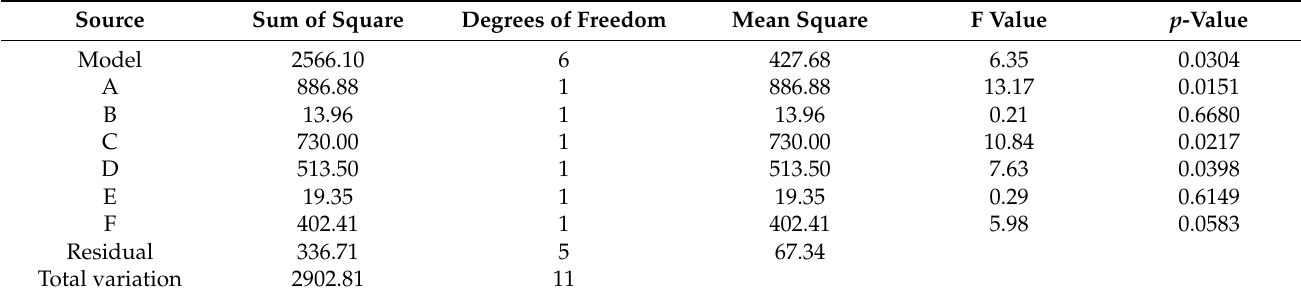
Table 3. Model summary statistics for quadratic model of 5-day average desulfurization efficiency (R1).